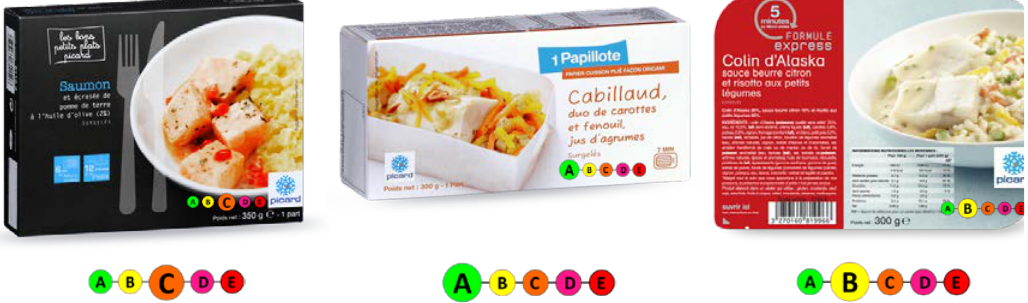
Figure 1. Screenshot of the stimulus material used in the study.